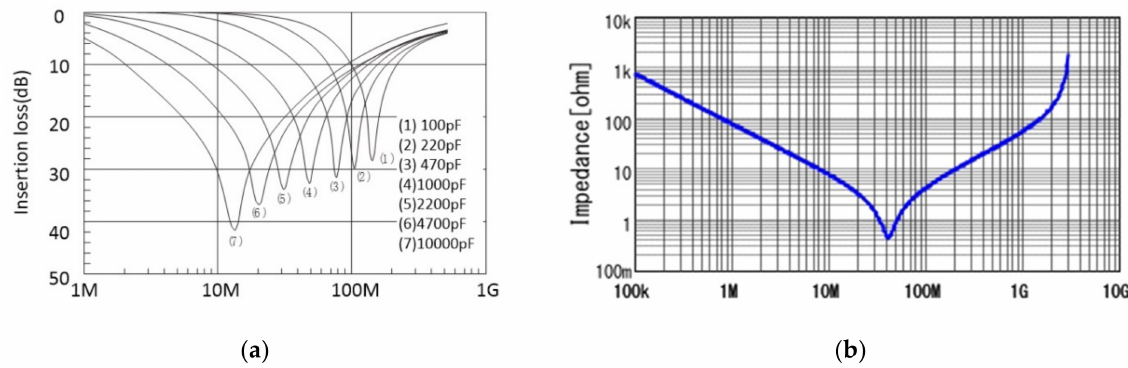
Figure 16. 2200pf C y capacitancecharacteristics: ( a )insertionloss-frequencycharacteristics; ( b